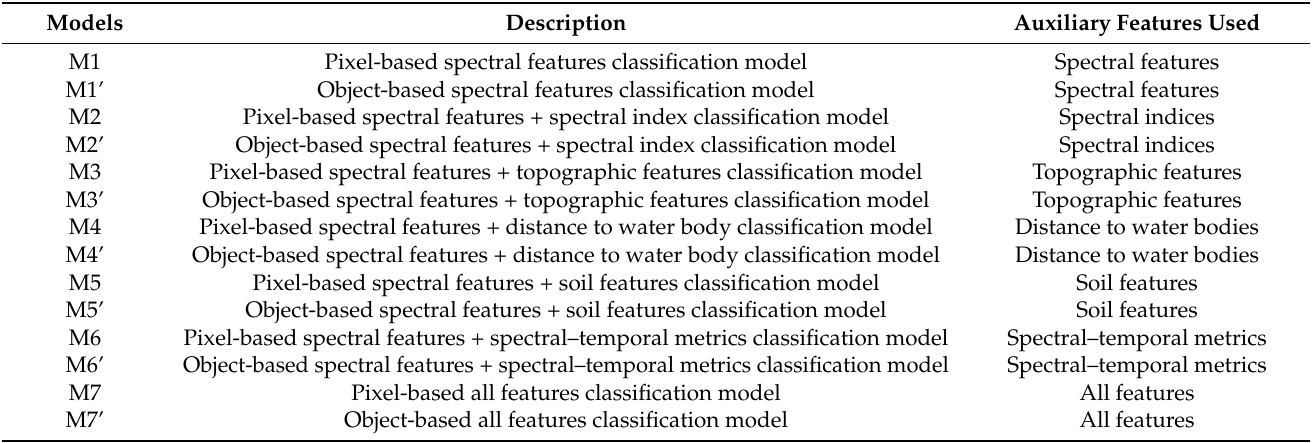
Table 3. Models used in this study for LULC